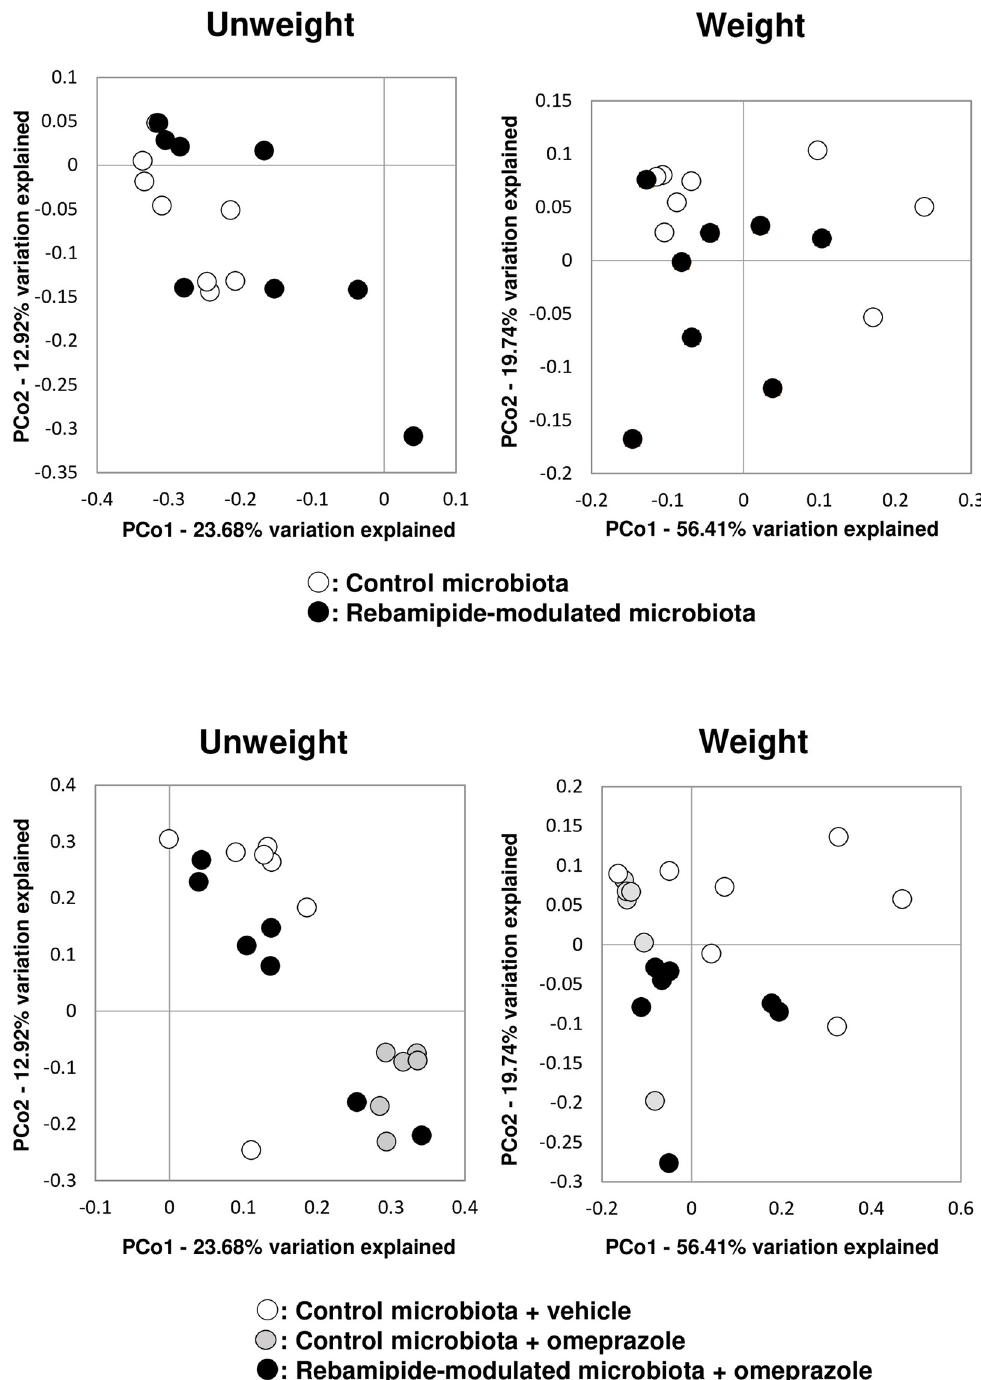
Fig 4. Principal coordinate analysis (PCoA) of unweighted and weighted UniFrac distances of small intestinal microbiota.